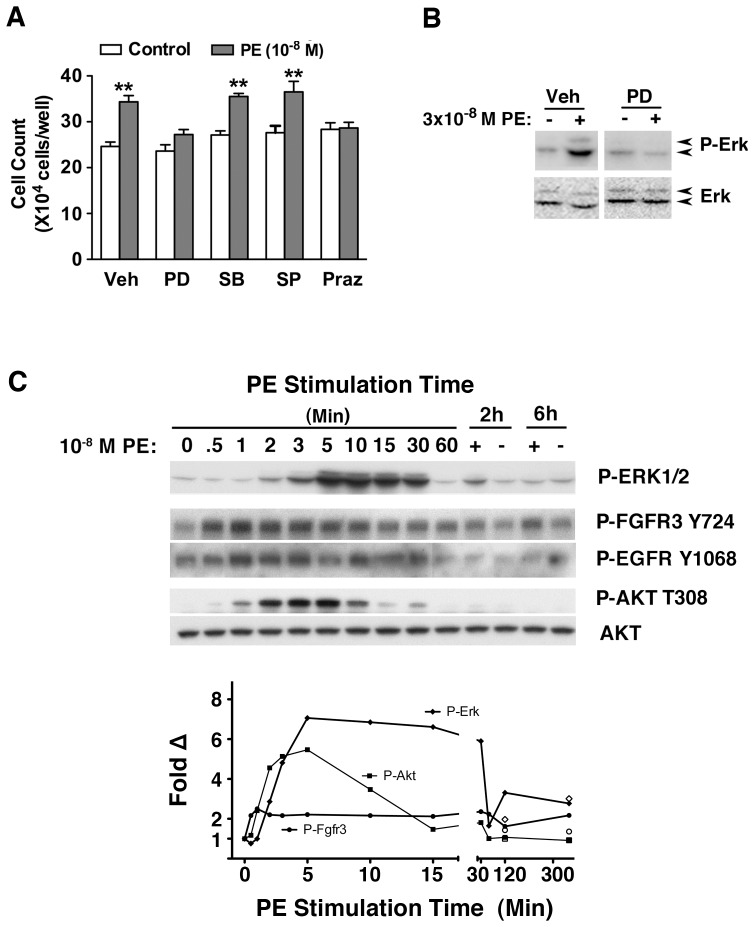
Low dose α1aAR stimulation activates growth-associated signaling.α1aAR expressing cells were placed into SF media prior to pretreatment and stimulation. (A) Prior to counting, cells were pretreated for 30 min with vehicle (0.1% DMSO), 20 µM PD98059 (MEK/Erk inhibitor), 10 µM SB203580 (p38 inhibitor), 10 µM SP600125 (Jnk inhibitor), or 10 µM Prazosin (α1AR) and then stimulated with 10 µM PE for 24 h. Values are the mean±SEM (n≥3); (*), P<0.05, compared to vehicle or inhibitor alone. (B) 20 µM PD98059 blocks PE-induced Erk phosphorylation. (C) Erk is acutely activated within 2 min of 10 µM PE addition and remains robustly phosphorylated for 15–30 minutes. Prior to Erk activation, stimulation induces sustained phosphorylation of EGFR and FGFR and acute transient phosphorylation of Akt at T308 downstream of PI3K/Akt signaling. Total Akt provides the load control for this multiply reprobed blot. In the lower panel, differences in temporal activation patterns are shown following semi-quantitative analysis of Erk, FGFR and Akt phosphorylation. Results represent the fold increase in phosphorylation relative to basal signal (Erk, FGFR3) or for Akt, background (arbitrary) signal.